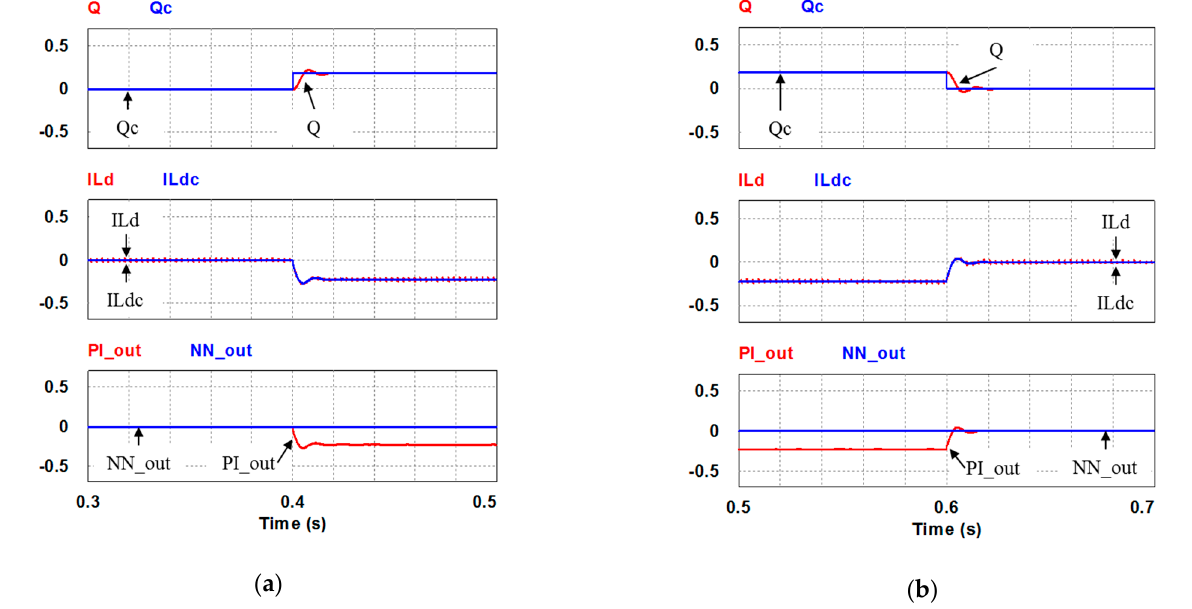
Figure 17. Detailed views of Figure 16 ( a ): ( a ) from 0.3 to 0.5 s; ( b ) from 0.5 to 0.7 s.